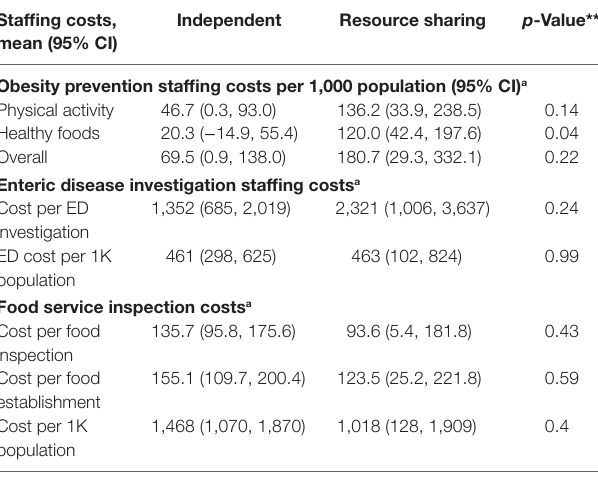
TaBle 8 | Staffing costs for obesity prevention, enteric disease control, and food service inspection programs. staffing costs, mean (95%